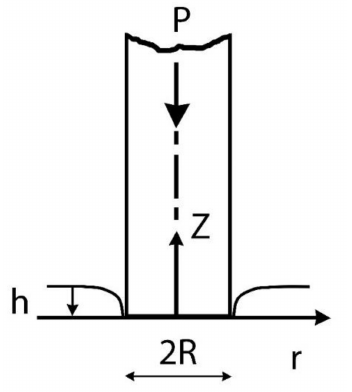
Figure 1. Schematic view of indentation by a flat-ended